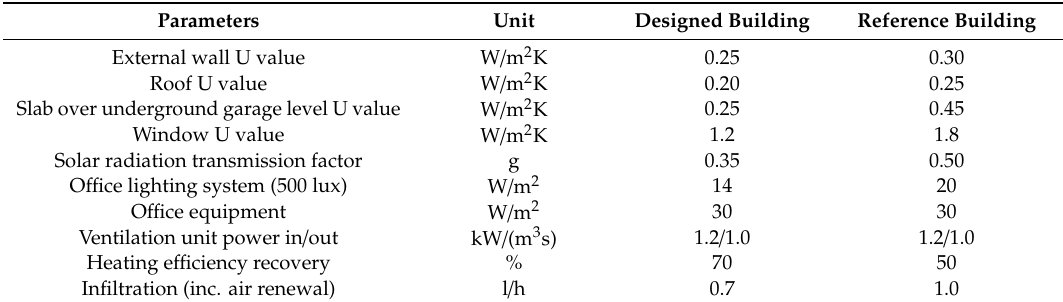
Table 4. Designed and reference building characteristic